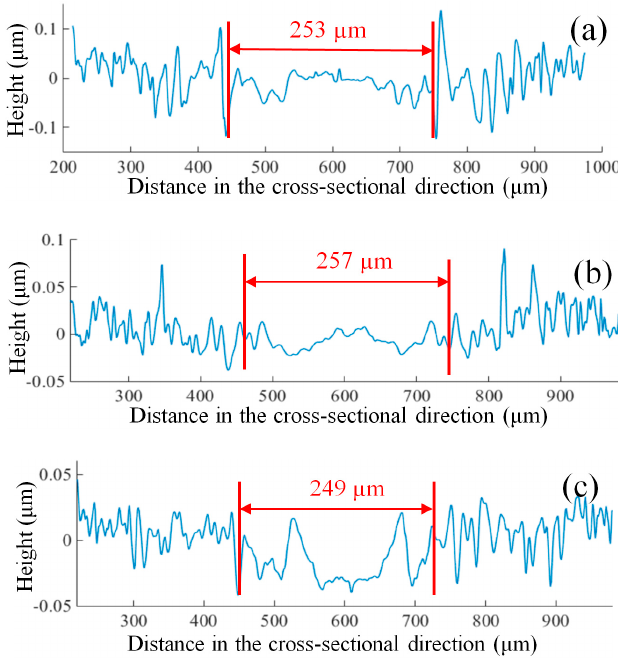
Figure 9. Cross-sectional profiles with a cutting depth of ( a ) 20 µm, ( b ) 30 µm and ( c ) 40 µm.